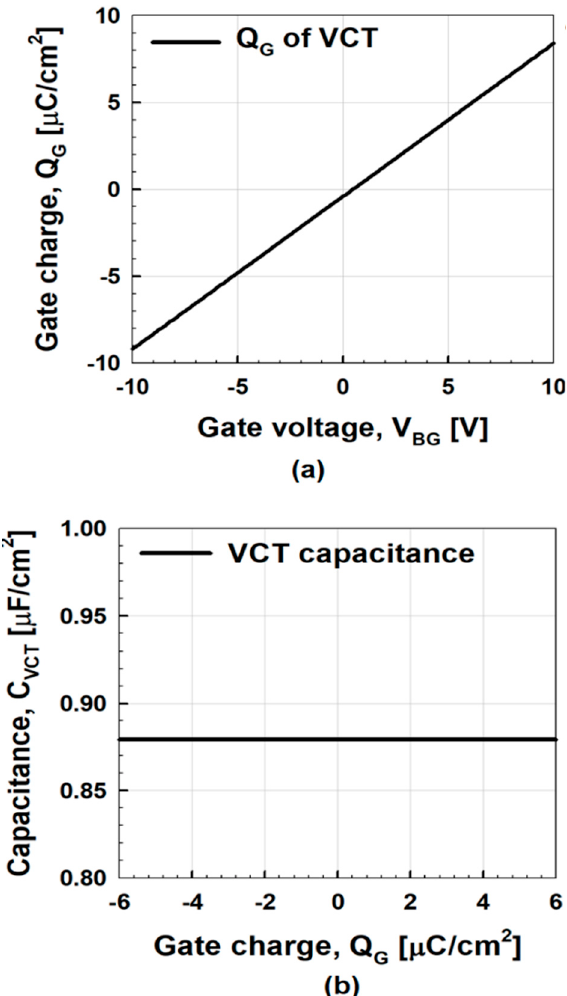
Figure6. ( a ) V BG vs. Q G and( b )vacuumchanneltransistor( C VCT )vs. Q G Figure 6. ( a ) V BG vs. Q G and ( b ) vacuum channel transistor ( C VCT ) vs. Q G of vacuum channel transistors.